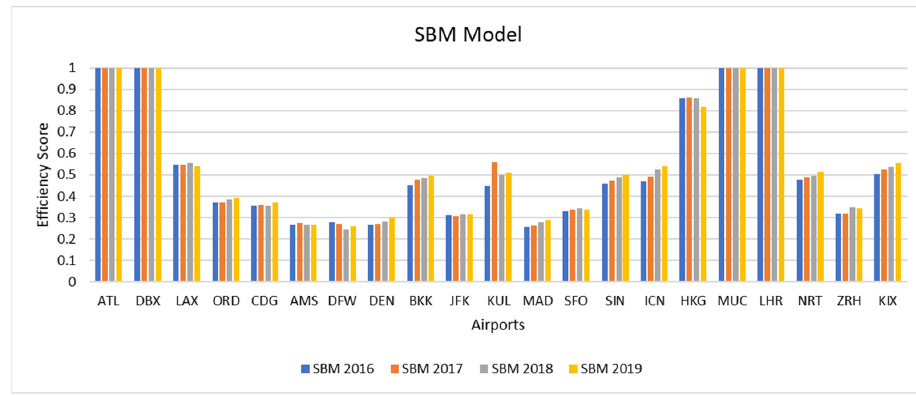
Figure 6. Efficiency score of the EBM model. As mentioned before, the SBM model is an adjusted CCR model so we can see the similarity of the result of both models. On the other hand, the BBC model is known for determining the pure technical efficiency of DMUs—in Figure 4 airports Hartsfield Jack- son Atlanta International Airport (ATL), Dubai International Airport (DBX), Suvarna- bhumi International Airport (BKK), KL International Airport (KUL), Hong Kong Interna- tional Airport (HKG), Munich International Airport (MUC), London Heathrow Airport (LHR), Narita International Airport (NRT), and Kansai International Airport (KIX) achieved the strongest efficiency, and O’Hare International Airport (ORD) achieved the